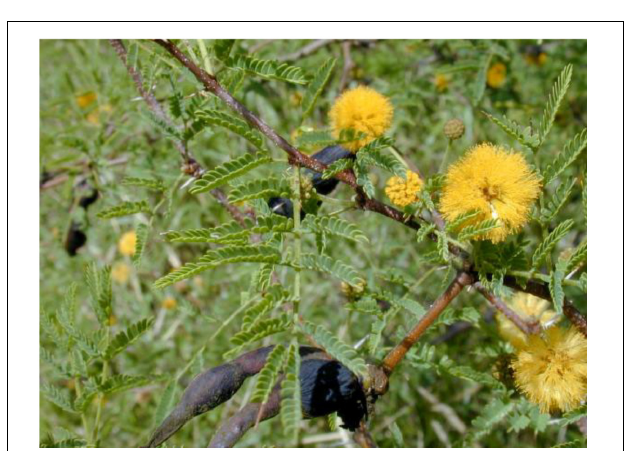
FIGURE 3 | Polytene chromosome and Chromosome Puffs, also named Balbiani rings. During transcription DNA strands in bands can uncoil, or puff. Thus bands indicate the presence of (clusters of) genes, while interband regions are devoid of genes. Chromatin remodeling is part of the (in)activation of gene (clusters). From Google images (Biology exams 4U: author not mentioned). Copyright permission not required.